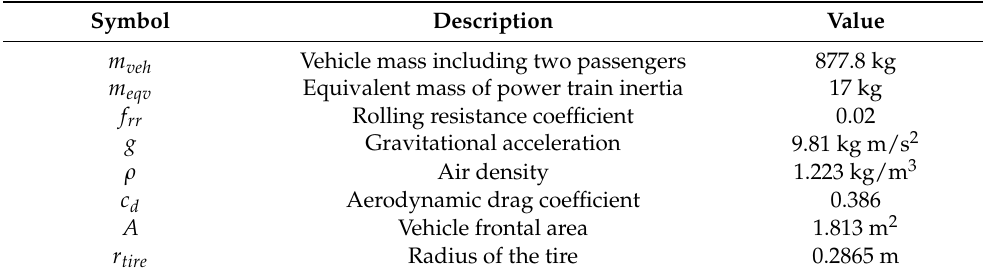
Table 3. Vehicle parameters